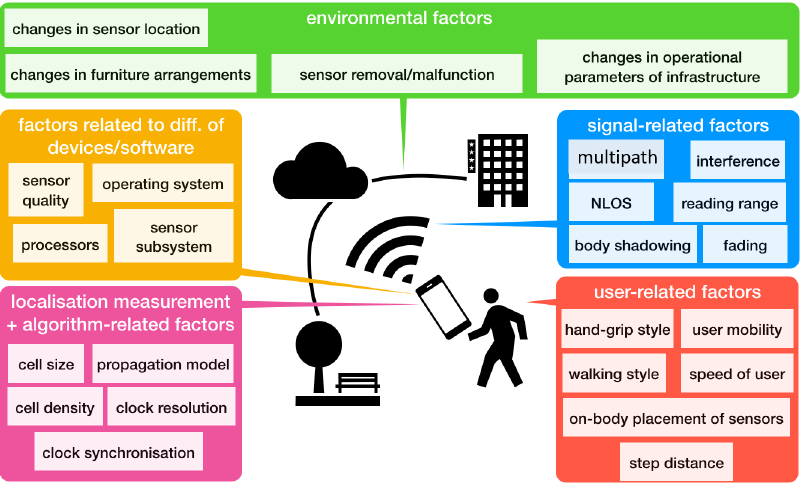
Figure 3. Factors that affect the quality of location